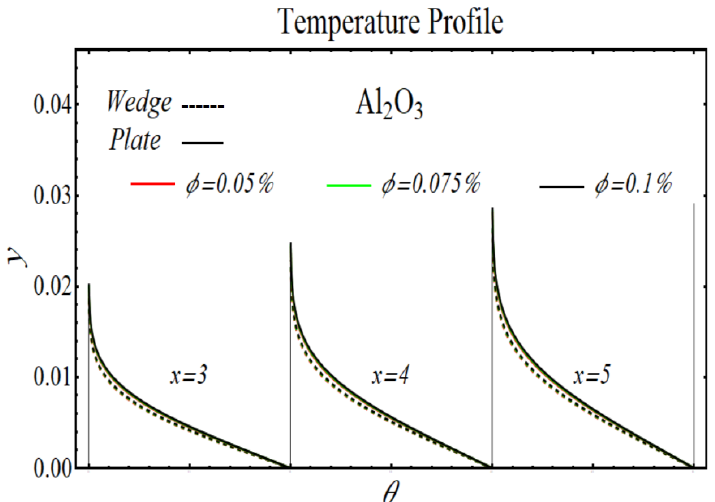
Figure 25. The temperature profile of Al 2 O 3 /DIW nanofluids over the wedge and plate under the impact of nanoparticle volume fraction.